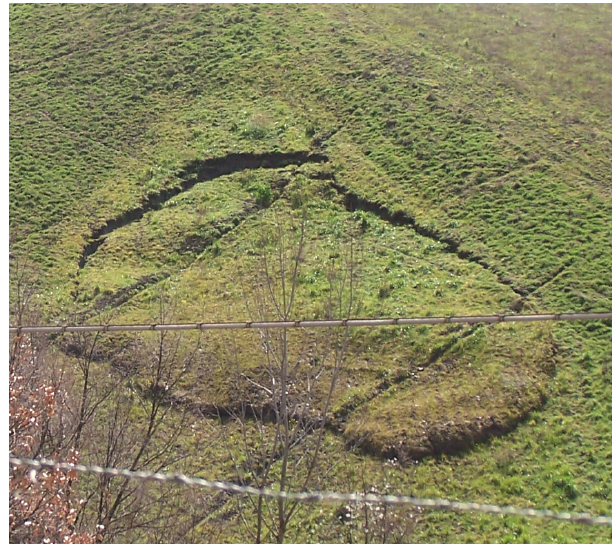
Figure 8. Initiation of slip at Castel Vecchio, Italy, that did not re- sult in a landslide in the geomorphic sense, but is considered as one in the engineering sense. See text for details.